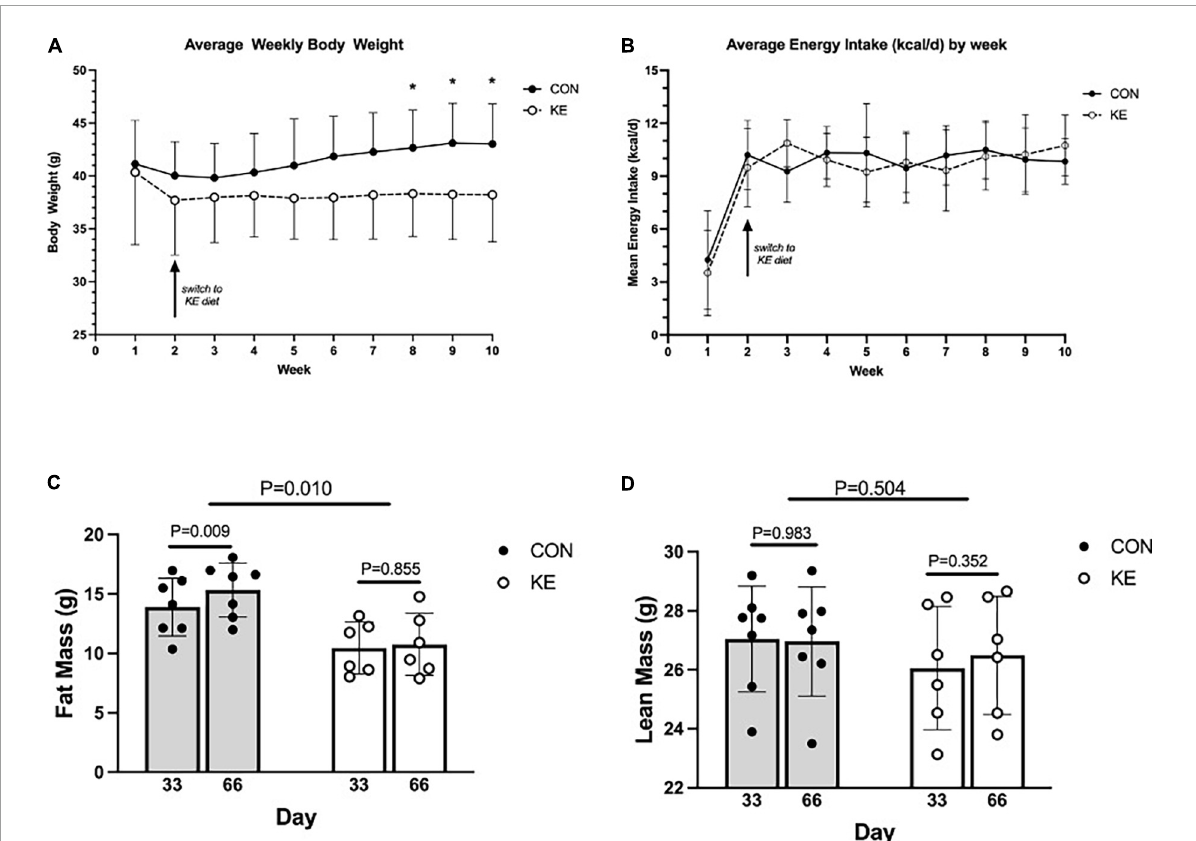
FIGURE1 (A) Weekly mean body weight of ketone ester (KE) mice was significantly less than control (CON) mice only during the last 3 weeks of the dietary intervention. (B) Weekly energy intake was similar between CON and KE groups. (C) Fat mass measured by quantitative magnetic resonance (QMR) was greater in CON compared to KE mice, and increased from day 33 to day 66 in CON mice only. (D) Lean mass measured by QMR was not different between CON and KE mice despite KE mice weighing less than CON